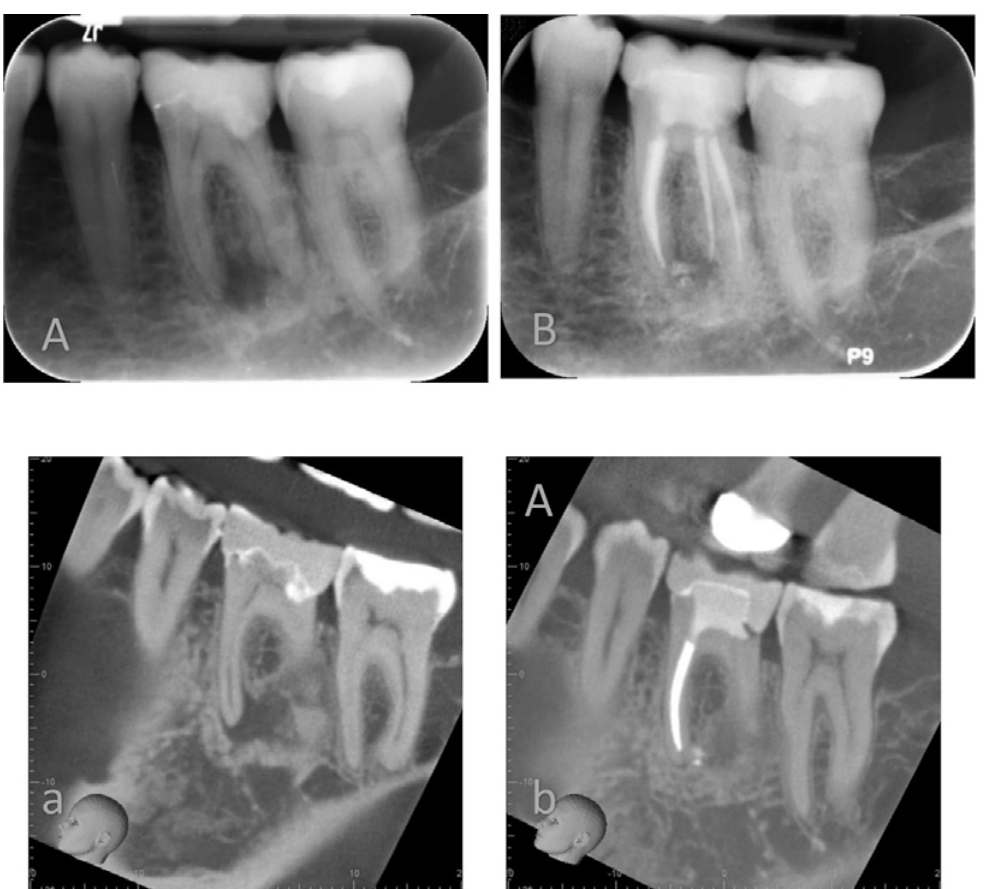
Figure 2. Lower left mandibular first molar root filled using a warm vertical condensation technique and AH plus root canal sealer. Preoperative Periapical X-ray ( A ) and Cone Beam Computer Tomography ( a ) and recall PA X-ray ( B ) and CBCT ( b ) at 12